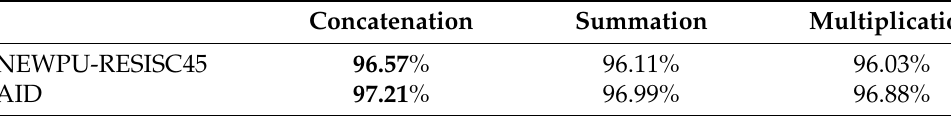
Table 3. Effect of different fusion strategies.